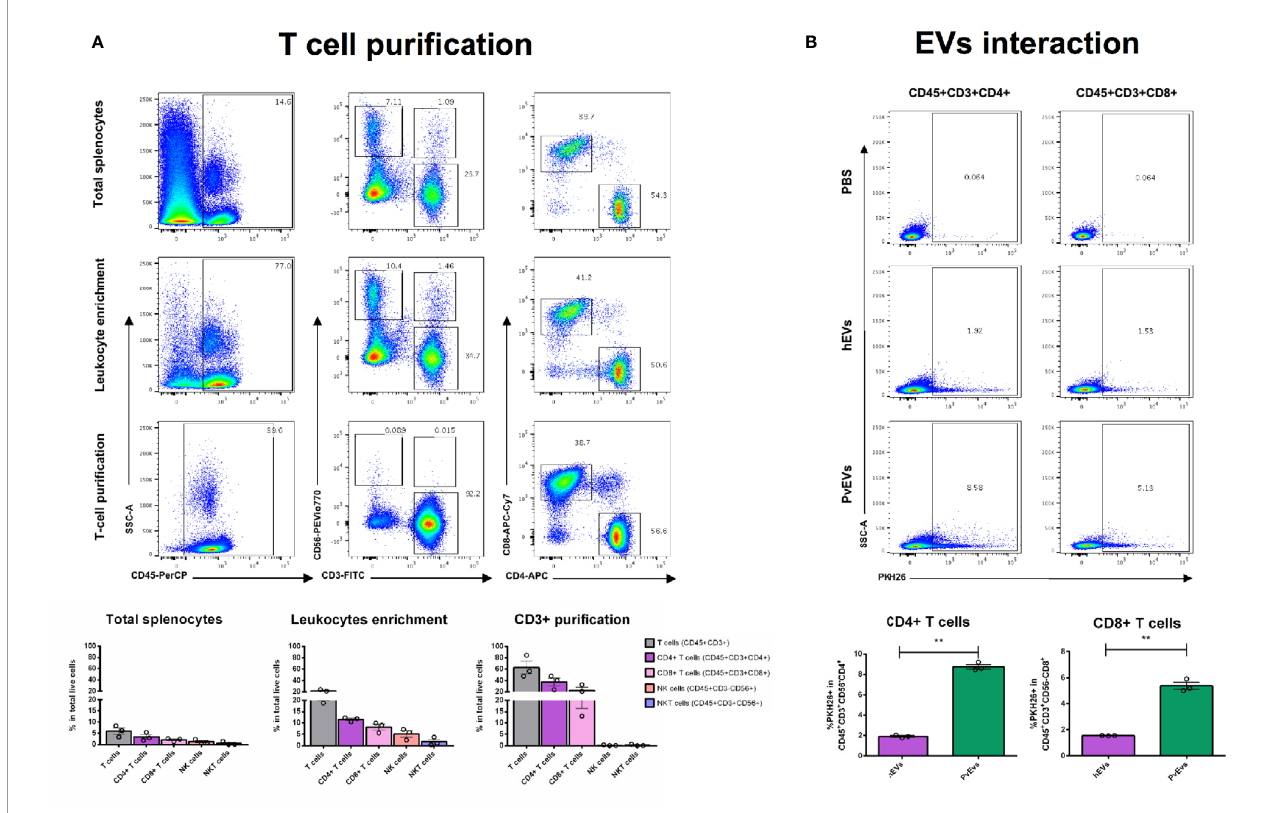
FIGURE 3 | Pv EVs and h EVs in vitro interaction with spleen T cells. (A) T cell puri fi cation. T cells were puri fi ed from spleen cell suspensions by a two-step procedure as shown in Figure 2 . Cells from all puri fi cation steps were stained with fl uorescent-conjugated antibodies against surface markers and analyzed by fl ow cytometry. Representative images show plots of the gating strategy to follow T cell puri fi cation. Enrichment quanti fi cation shown corresponds to the mean of two puri fi cations from two spleen donors processed independently by negative selection. (B) Pv EVs and h EVs in vitro interaction with spleen T cells. Flow cytometry plots showing frequencies of CD4 + and CD8 + T cells positively labeled with PKH26. PKH26 staining was gated according to cells incubated with PKH26-stained PBS. Frequencies quanti fi cation of three technical replicates is shown. Data is representative of two independent experiments performed with two spleen donors. Statistical signi fi cance (P<0.05) was assessed using a Student ’ s t -test , **p <